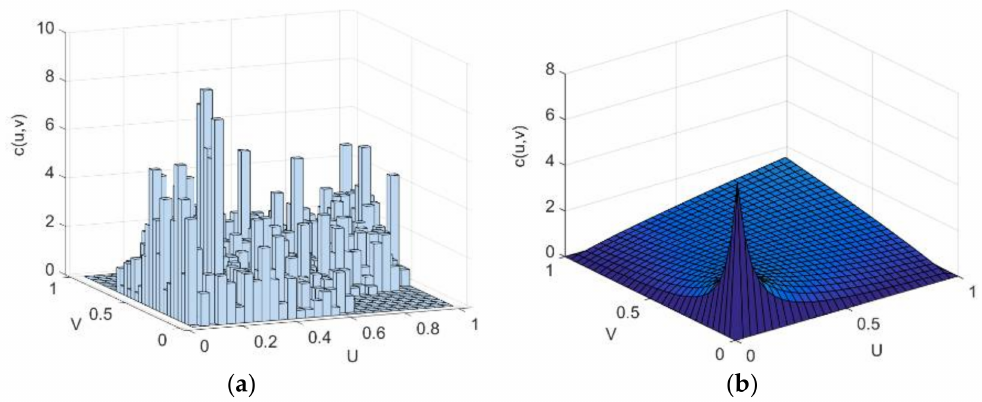
Figure 9. ( a ) The binary frequency histogram and ( b ) the graph of the binary probability density function. (Note: U denotes marginal distribution of temperature; V denotes marginal distribution of O 3